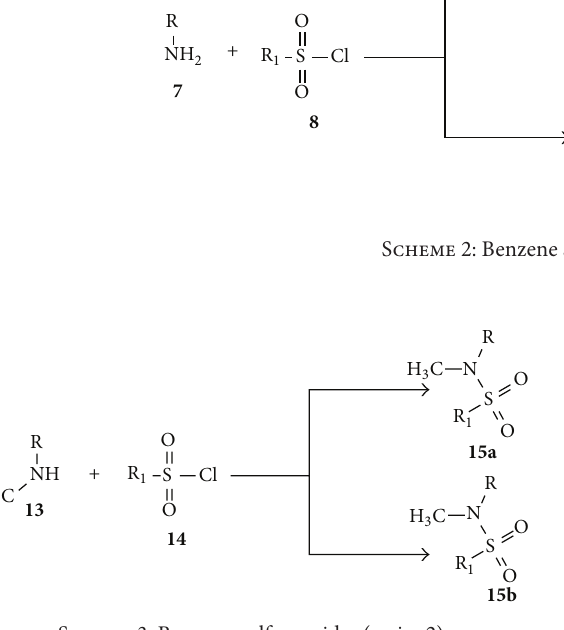
concentration of tested compounds after twofold serial dilu- tion. Five individually numbered test tubes with screw caps were sterilized. Tube 1 was filled with 2 mL of tryptic soy broth culture media including the stock solution of synthesized compounds. 1.0 mL of this solution was introduced into 2 tubes and diluted with 1.0 mL culture media and we repeated the procedure up to tube 5. The tubes were incubated at 25 ∘ C for 72 hrs. Ciprofloxacin and sulfamethoxazole (sulfa drug) were used as reference (positive control to